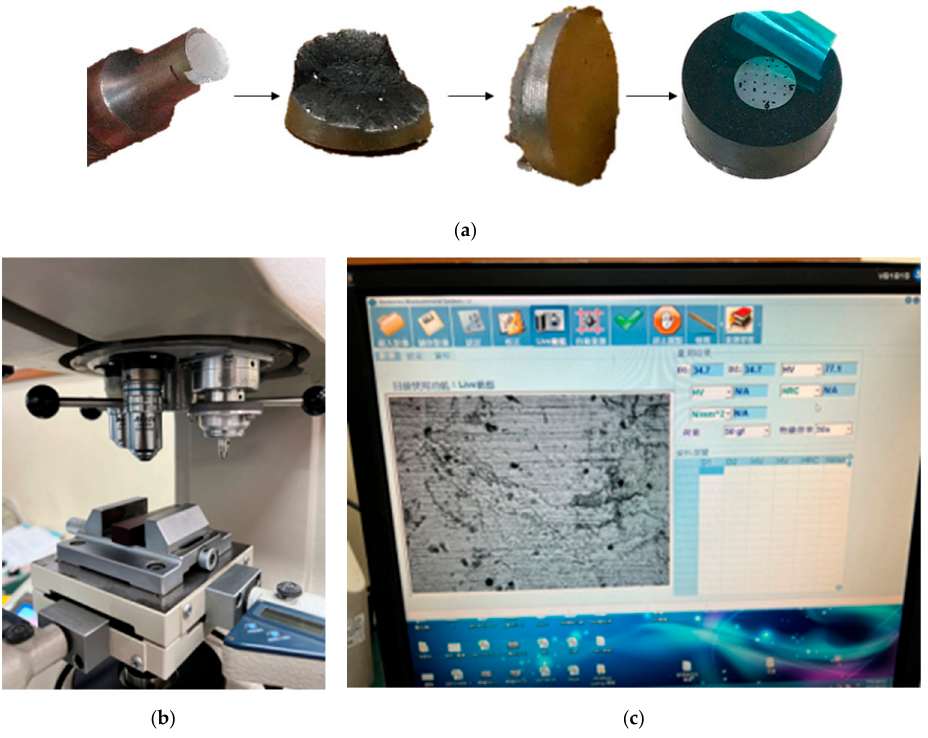
Figure 3. The data generation process applied by this study. ( a ) The sample used for tensile testing; ( b ) the Vickers hardness tester used in this study; ( c ) the usage of the Vickers hardness tester soft- ware.